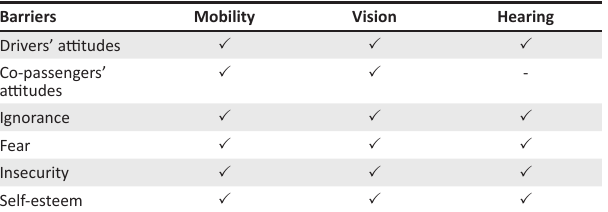
TABLE 3: Summary of psychosocial barriers.